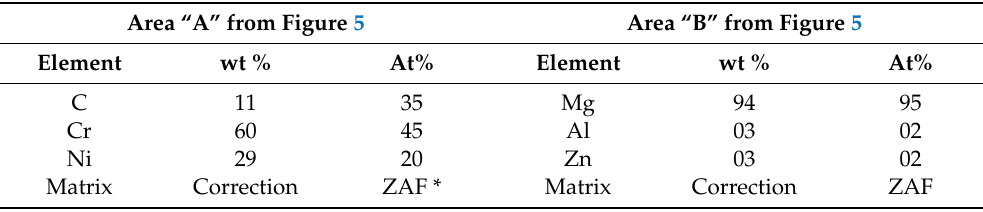
Figure 4. SEM cross-section images: area “A” coating and area “B” substrate ( a ) and the ( b ) EDS analysis of the coating. Table 2. Chemical composition of layer and substrate from the Figure 5. measurements to convert raw peak intensity into semi-quantitative concentrations corrected for inter-